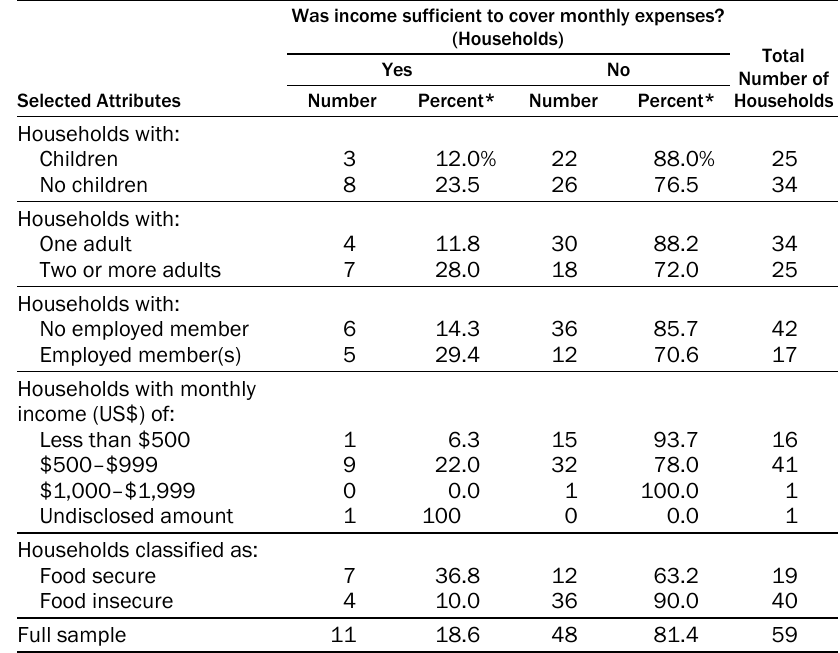
Table 2. Sufficiency of Household Income to Cover Monthly Expenses by Selected